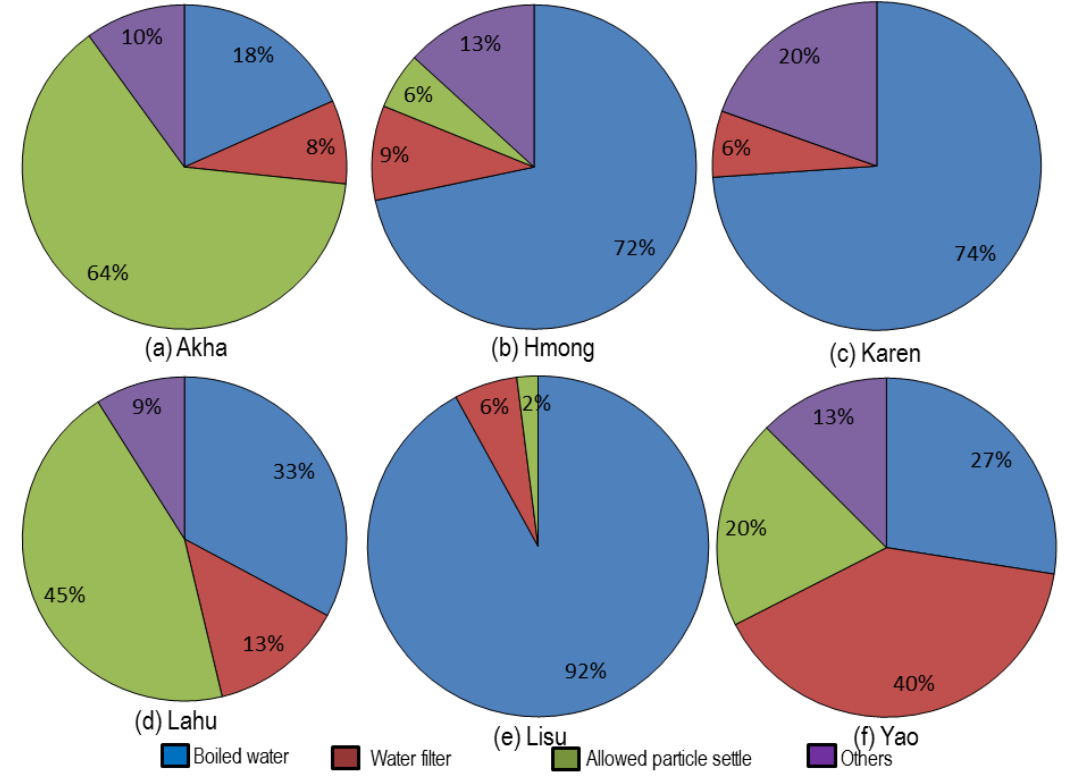
Figure 5. ( a – f ): Drinking water treatment at household level.